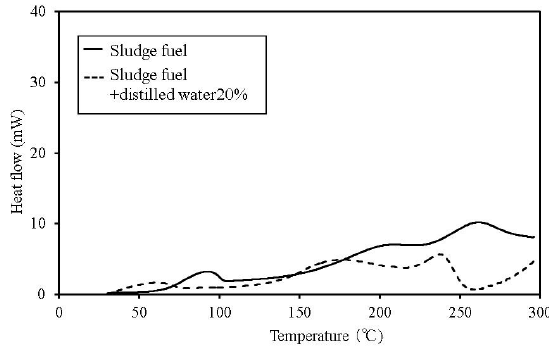
Figure 5. C80 calorimetry curves for wood pellets (made from tree trunks).